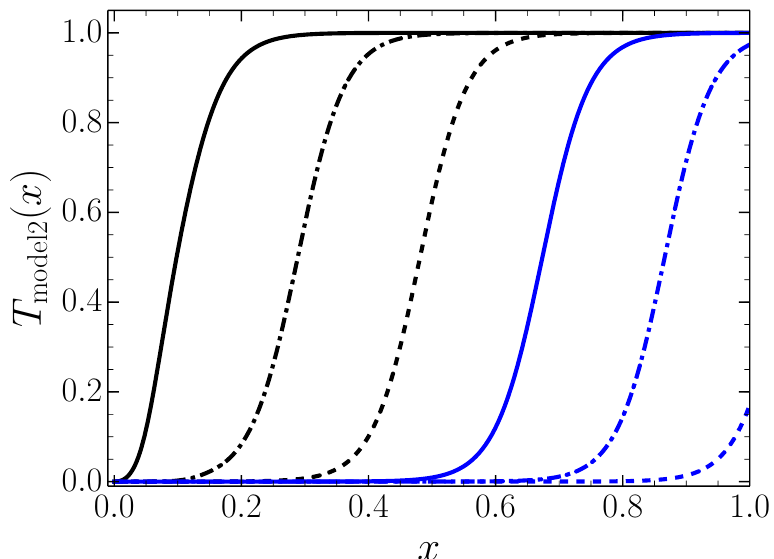
Figure 7. Regge–Wheeler for Schwarzschild: Scalar greybody factors . Toy model # 2 , Equation (39), for the greybody factors. From left to right the curves correspond to (cid:96) = 0 to (cid:96) = 5. Note improved behavior at x =